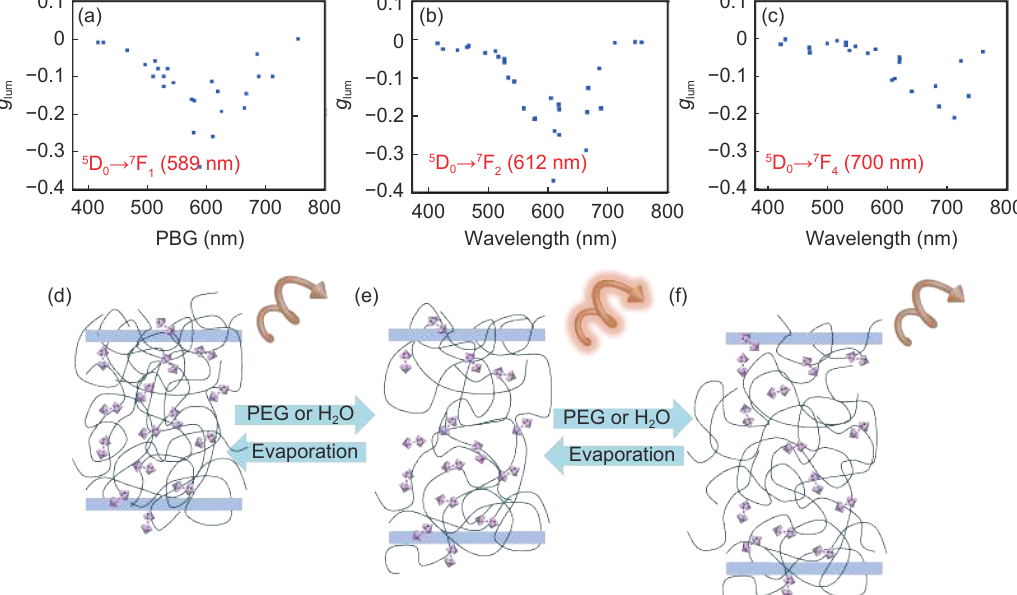
Figure 6 Diagram describing the relationship of the g lum and PBG: (a) emission peak at 589 nm corresponding to 5 D 0 → 7 F 1 transition, (b) emission peak at 612 nm corresponding to 5 D 0 → 7 F 2 transition, and (c) emission peak at 700 nm corresponding to 5 D 0 → 7 F 4 transition; (d) when PBG was smaller than emission wavelength, CPL was weak; (e) when PBG coincided with emission wavelength, CPL was the strongest; (f) when PBG was larger than emission wavelength, CPL became weak